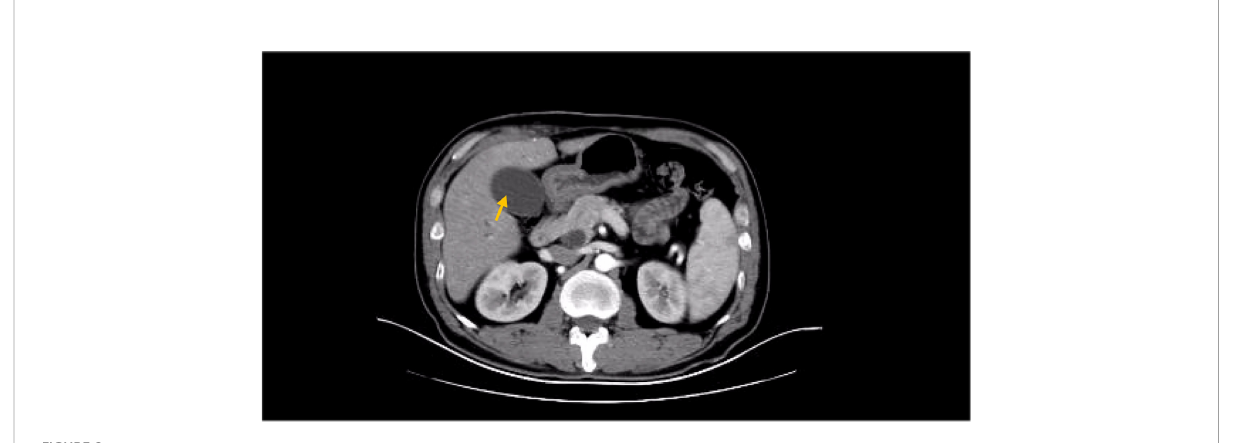
FIGURE 2 CT (enlargement of gallbladder due to biliary